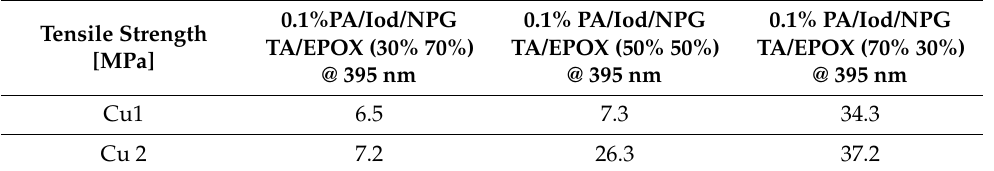
Table 7. The tensile strength of IPN materials as a result of hybrid polymerization of the TA/EPOX mixture using Cu/Iod/NPG (0.1%/1%/1% w / w / w ) as a photoinitiating